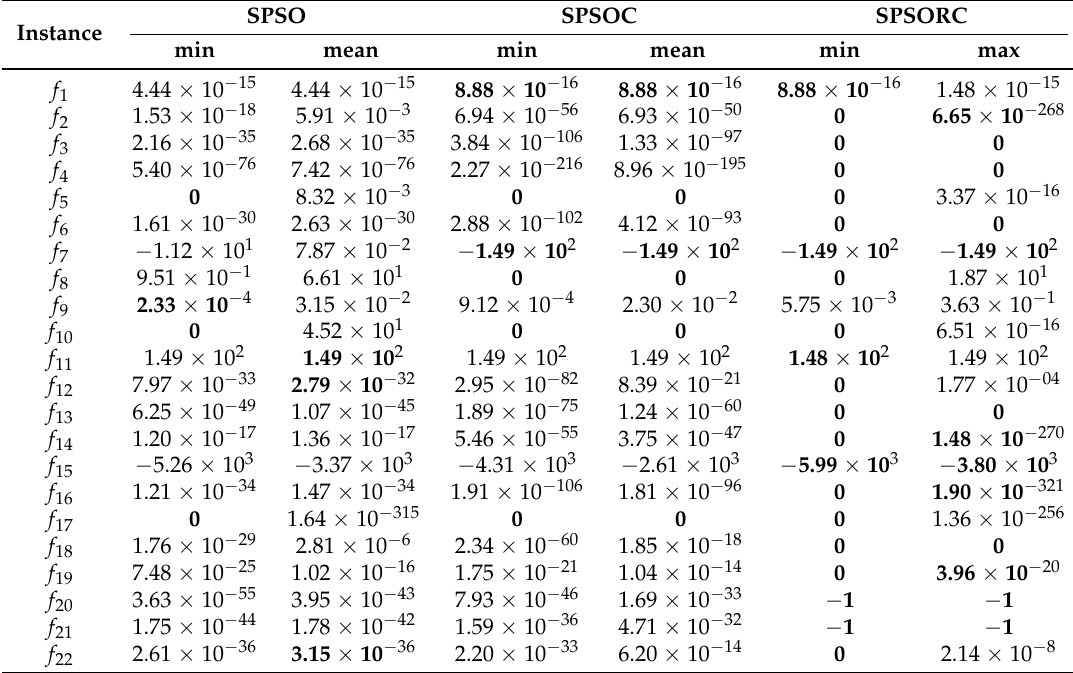
Table 4. Discussion on the necessity of improving